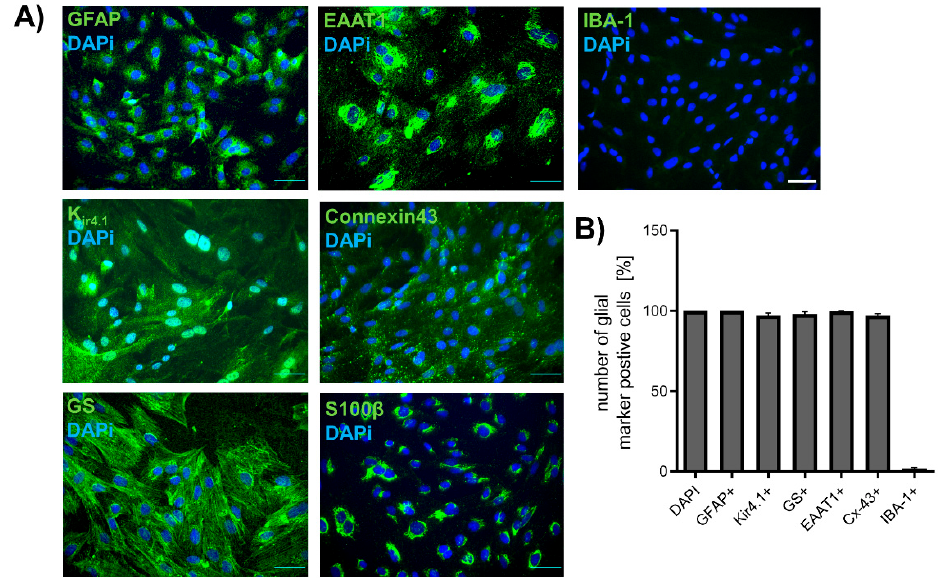
Figure 1. Isolation of spinal astrocytes from rats. ( A ) Immunocytochemical staining of different markers for astrocytes (GFAP, K ir4.1 , GS, EAAT1, Cx-43) and microglia (IBA-1) cultured cells from spinal cords of rats. ( B ) The percentage of GFAP-, K ir4.1 -, GS-, EAAT1-, or Cx43-positive cells were >97%, while only <2% of the cells were positive for IBA1. n = 4 individual experiments for each marker with >100 cells. Scale 50 µm.